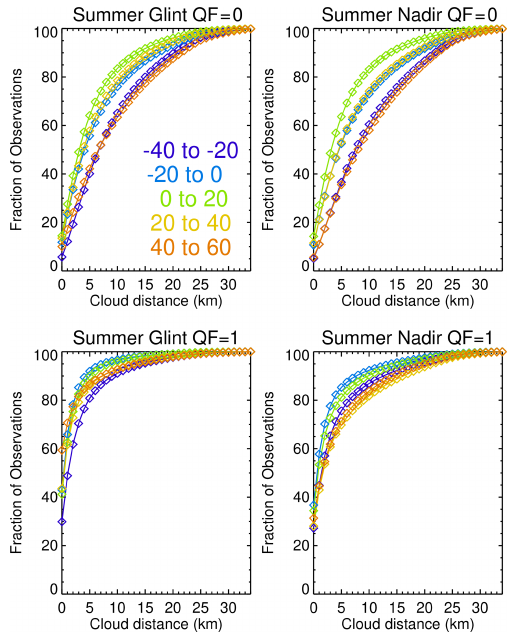
Figure 1. Fraction of observations that have a cloud within a cir- cle of a specified radius (given by the x axis values) in summer for ocean glint and land nadir lite file data points for QF = 0 (best qual- ity) and QF = 1 (lesser quality) data. Each curve is for a labeled 20 ◦ latitudinal band. QF = 1 fractions are generally larger than the QF = 0